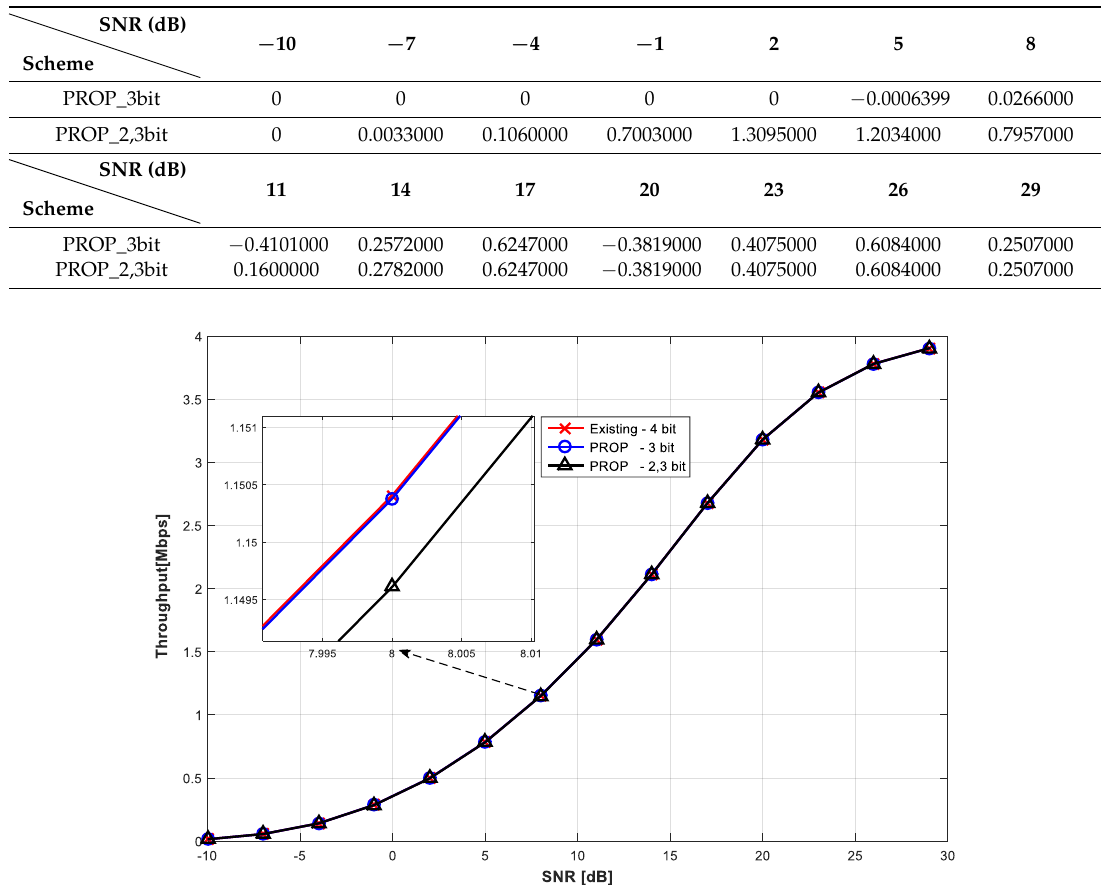
Figure 4. Comparison of system throughputs for CQI feedback schemes.